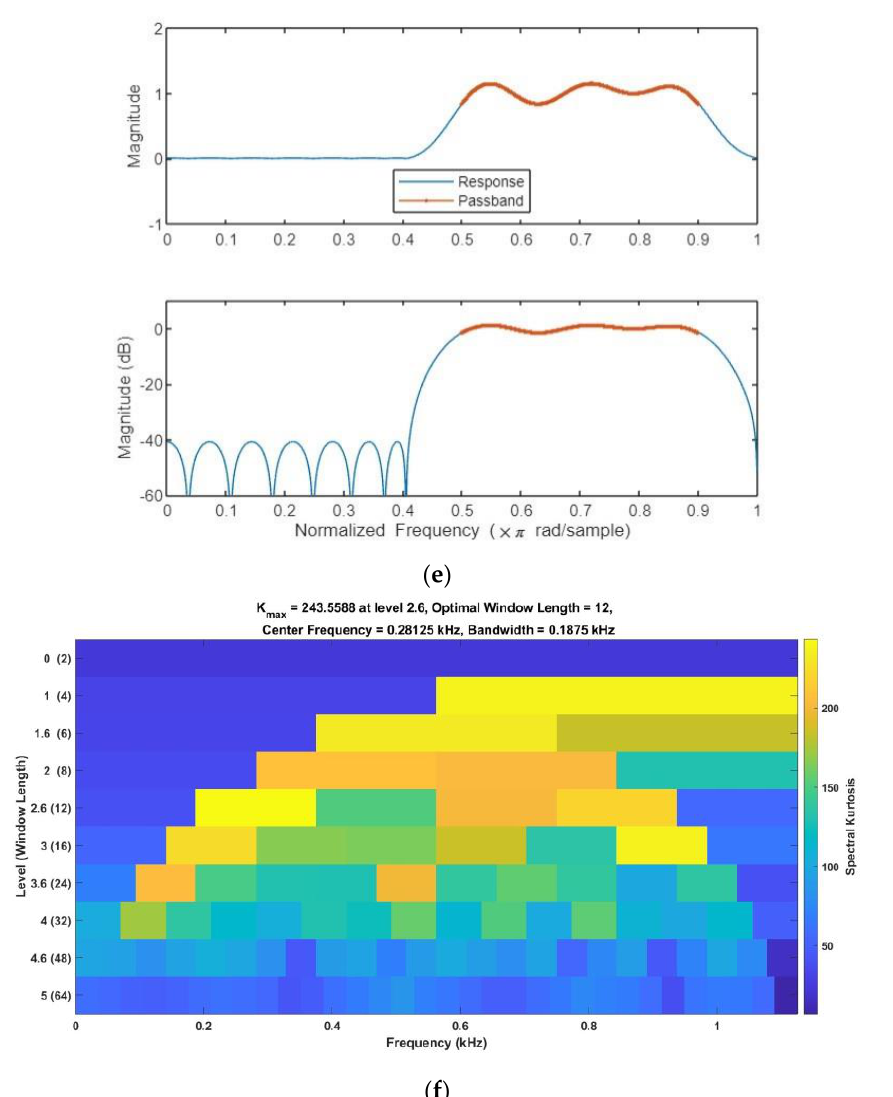
Figure 14. ( a ) Three phase CCHIF signal ( b ) zoom view CCHIF single phase signal ( c ) reconstructed signal ( d ) decomposed signal ( e ) 3 dB bandwidth ( f ) Kurtogram of CCHIF.